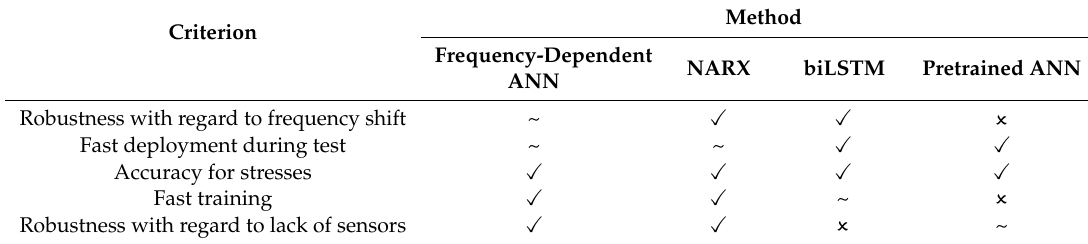
Table 5. Evaluation of models for various criteria.